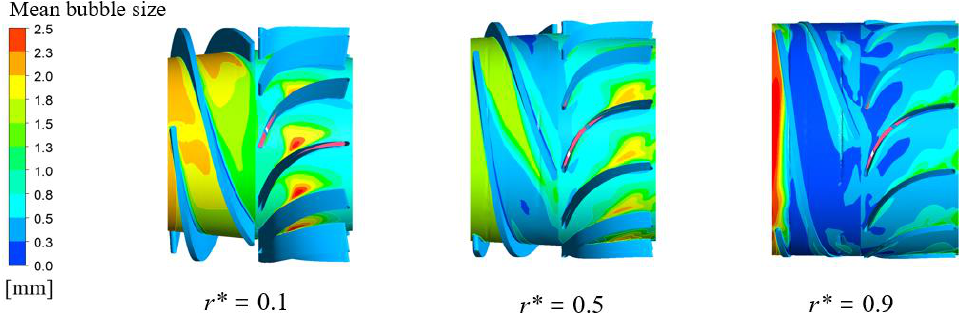
Figure 10. Circumferential mean bubble size distribution of the pressurization unit of the multiphase pump at 5%.